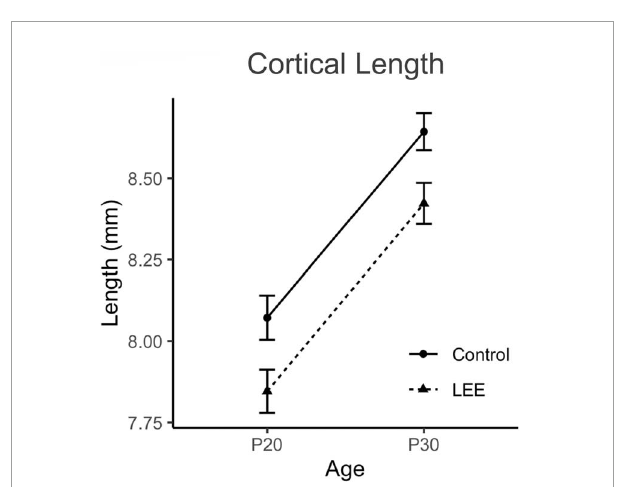
FIGURE5 Cortical lengths. No significant differences in cortical length were observed between control and LEE pups at P20 or P30 ( N = 70). Data expressed as mean ±